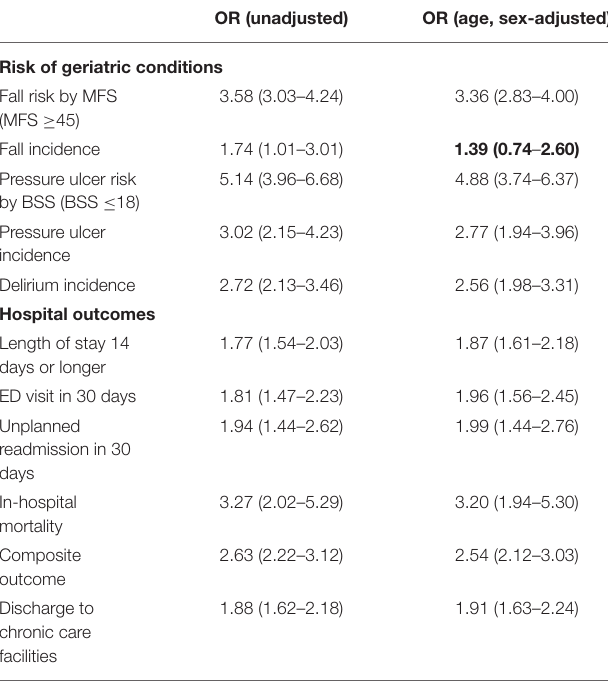
TABLE 2 | Associations between an increasing burden (1 point higher) of frailty by the Clinical Frailty Scale and the risk of geriatric conditions and hospital outcomes by the logistic regression